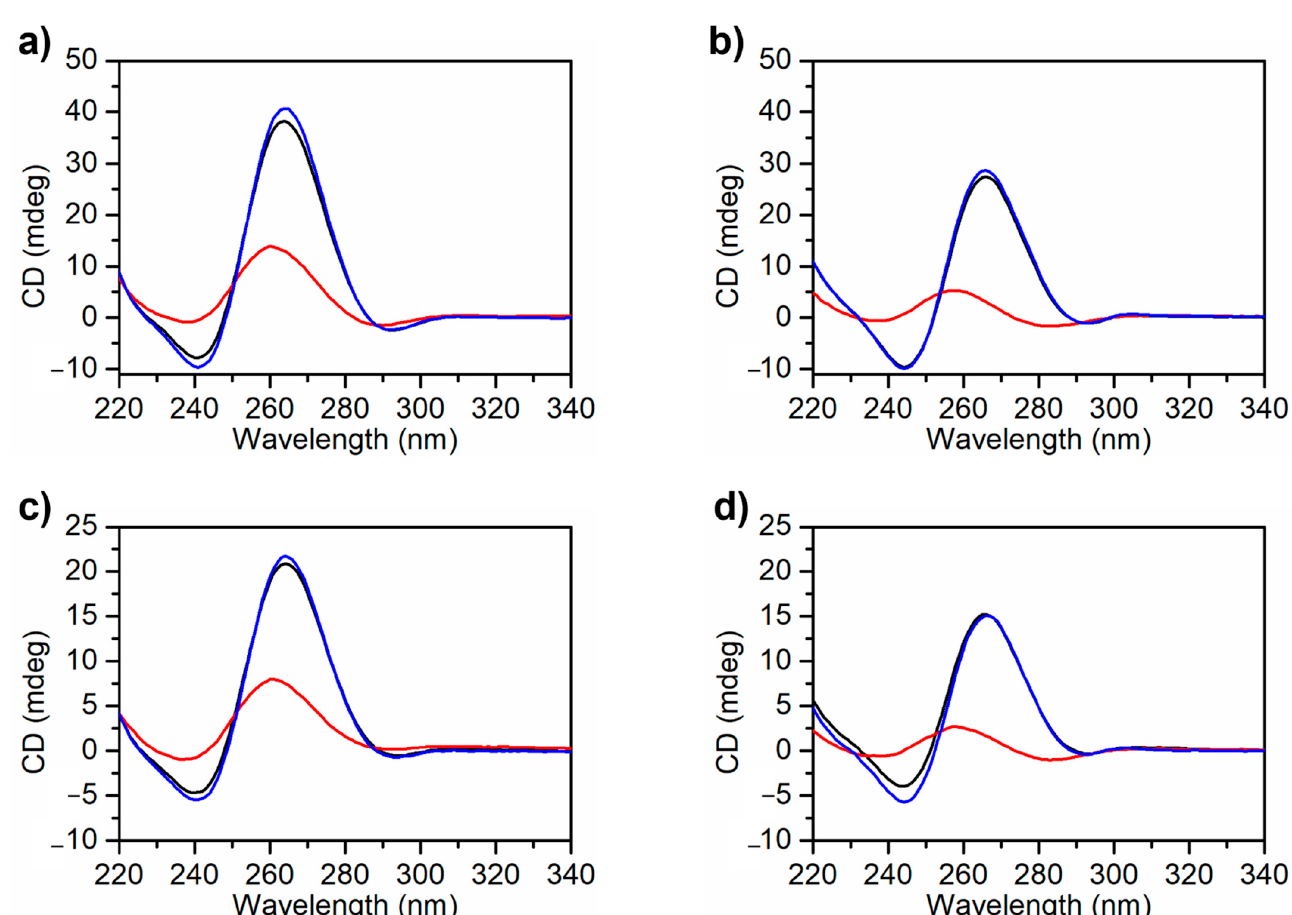
Figure 2. CD analysis of MS3 analogues: CD spectra of MS3-33 ( a ) and MS3-17 ( c ) in PBS buffer (137 mM NaCl, 2.7 mM KCl, 10 mM NaH 2 PO 4 /Na 2 HPO 4 , 1.8 mM KH 2 PO 4 /K 2 HPO 4 , pH = 7.4) at 5 °C before (black line), after melting/cooling (blue line), and at 100 °C (red line); CD spectra of MS3-33 ( b ) and MS3-17 ( d ) in the Na + buffer (10 mM NaH 2 PO 4 /Na 2 HPO 4 , 90 mM NaCl solution, pH = 7.0) at 5 °C before (black line), after melting/cooling (blue line), and at 100 °C (red line).